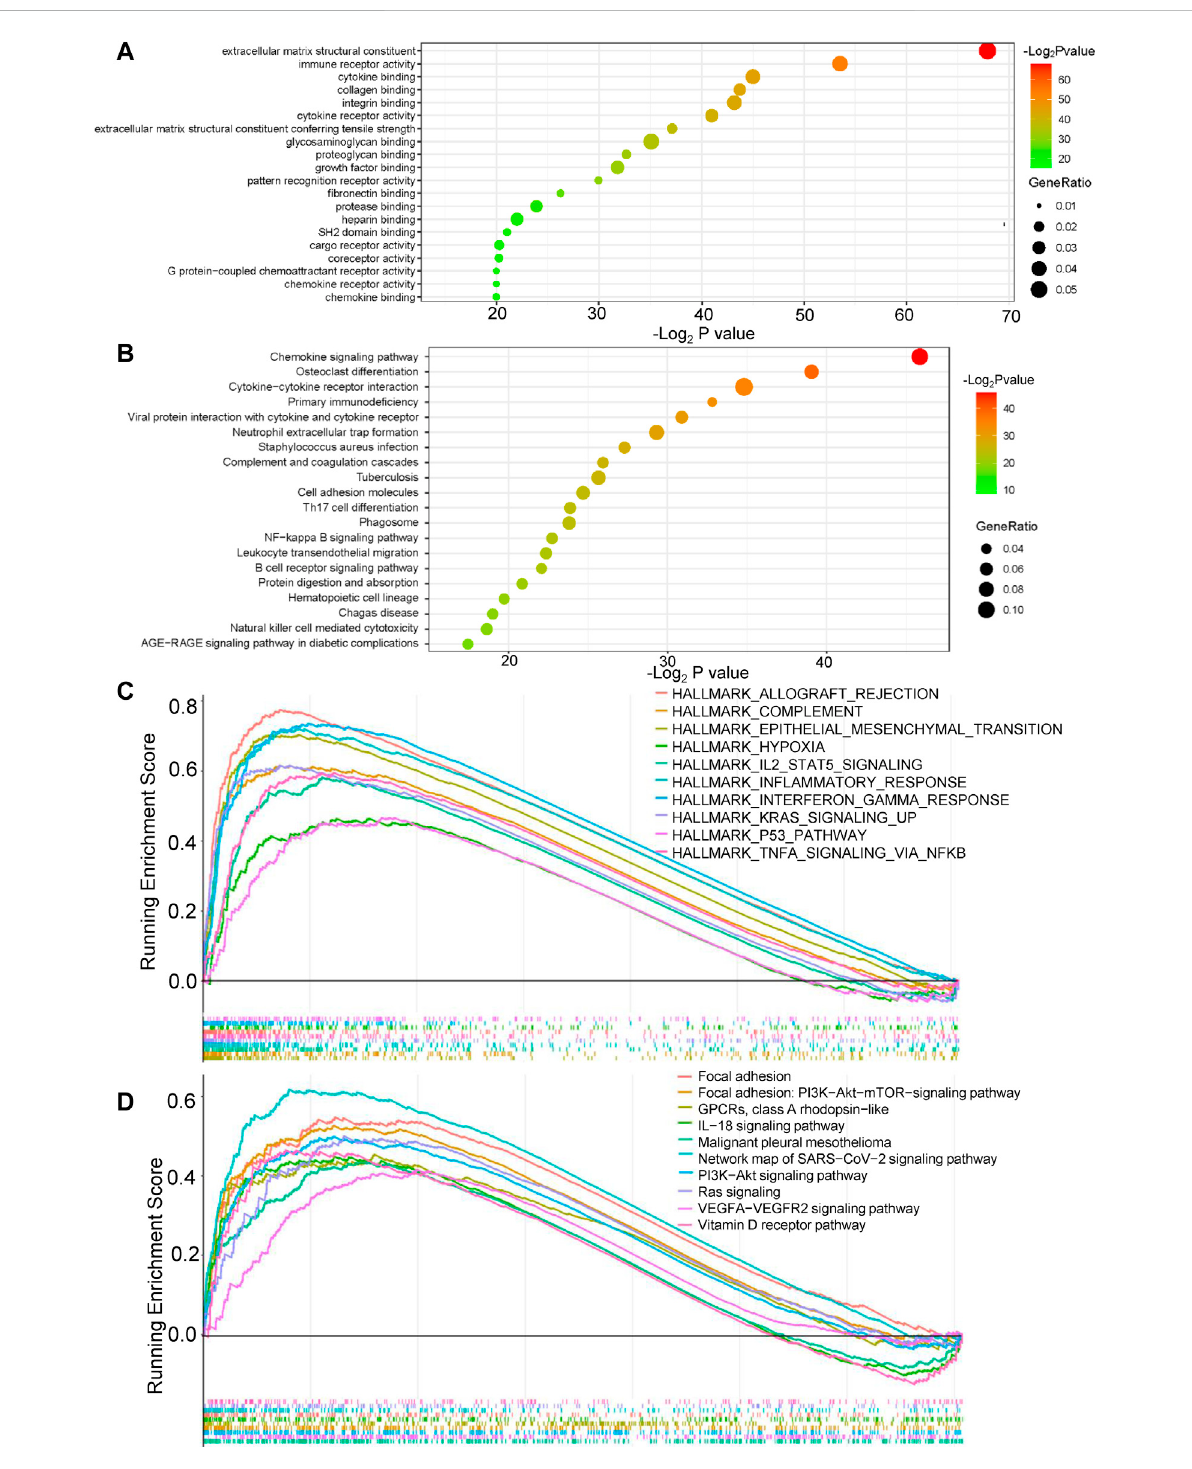
FIGURE 5 Functional enrichment analysis of the risk model. (A,B) Gene Ontology (GO) annotations and Kyoto Encyclopedia of Genes and Genomes (KEGG) enrichment analysis. (C) Gene set enrichment analysis (GSEA) in the MSigDB database of tumor hallmarks. (D) WikiPathways analysis.